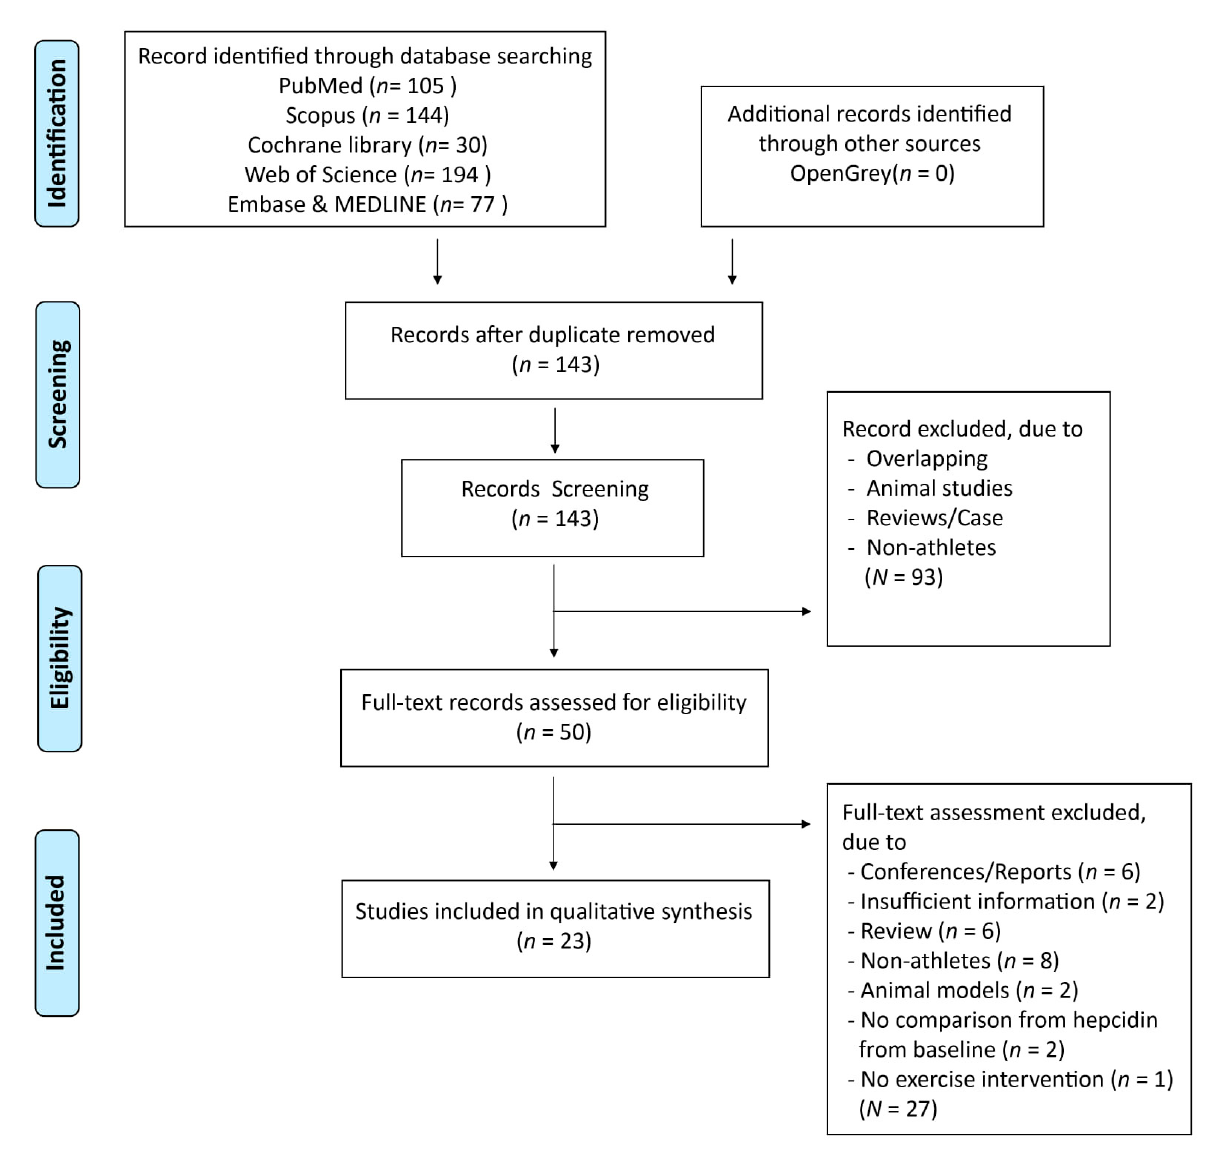
Figure 1. Flow diagram of selection process.